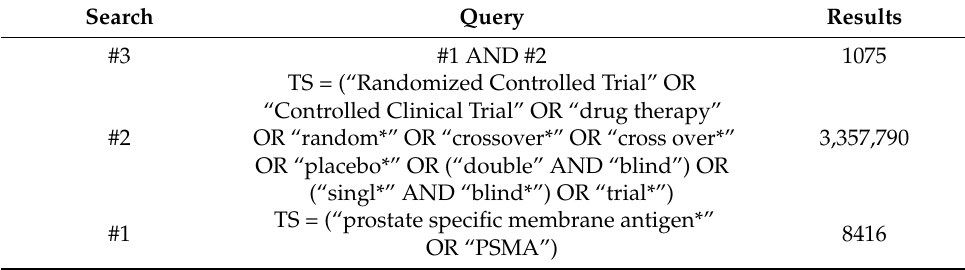
Table A3. Search strategy in Clarivate Analytics/Web of Science Core Collection.